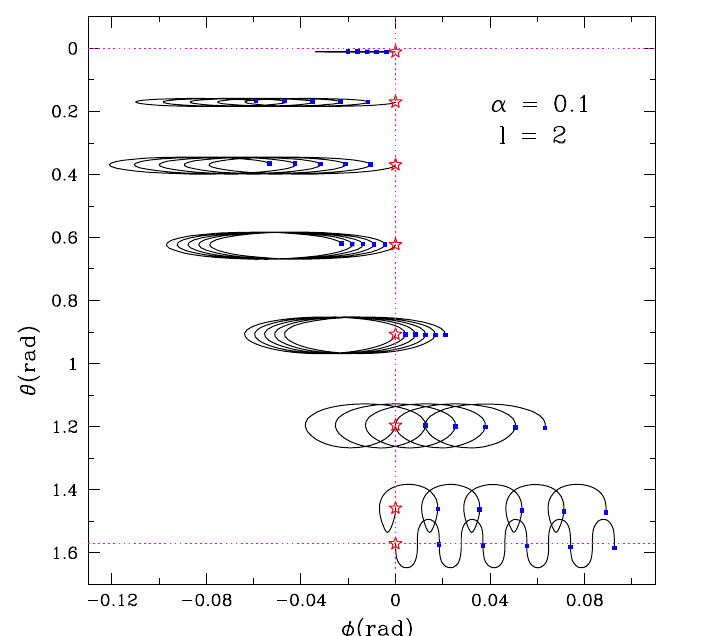
Fig. 19 Projected trajectories of several fiducial fluid elements (as seen in the corotating frame) for an l = m = 2 Newtonian r -mode. All of the fluid elements are initially positioned on the φ 0 = 0 meridian at different latitudes (indicated with stars). Blue dots indicate the position of the fluid elements after each full oscillation period. The r -mode induces a kinematical, differential drift. (Image reproduced with permission from Rezzolla et al. 2001a, copyright by